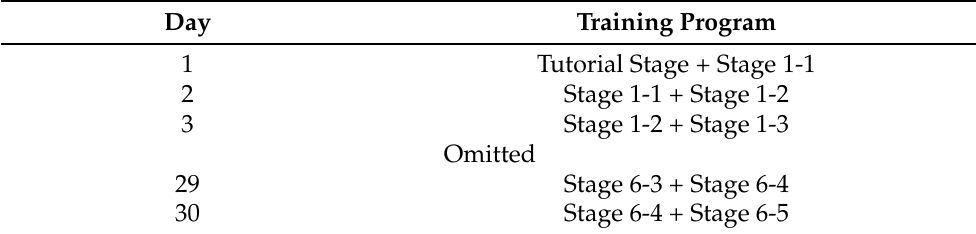
Table 1. Order of the provision of